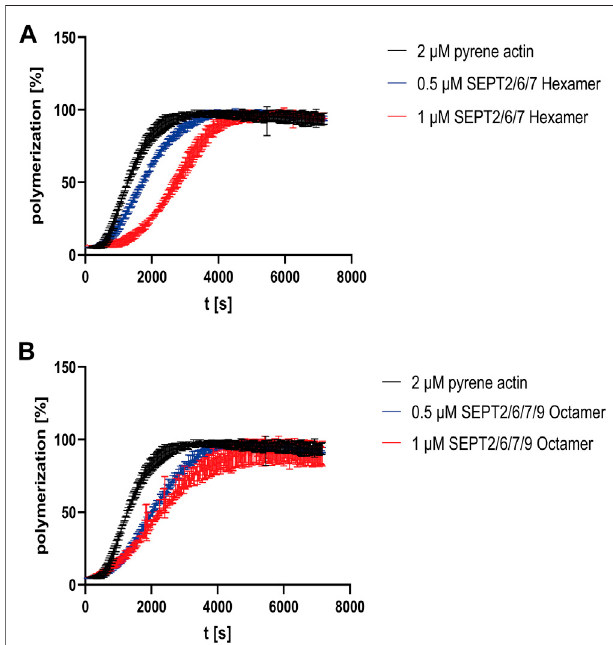
FIGURE 3 | In fl uence of human septin rods on actin polymerization. (A) Actin polymerization assay using pyrene actin with and without septin hexamers. (B) Actin polymerization assay using pyrene actin with and without SEPT9 G568 containing octamers. The assays shown were performed in triplicate and in quintuplicate for actin. The same averaged actin curve was used for evaluation of the assay. The unprocessed raw data are shown in Supplementary Figure S4 .